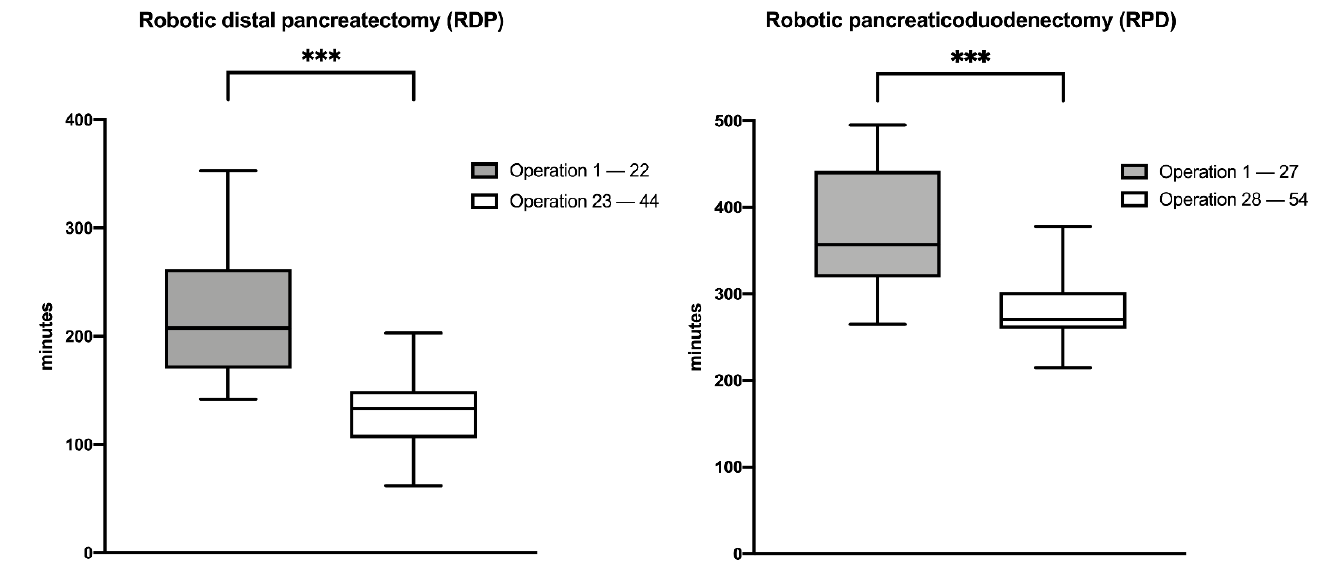
Figure 2. Development of procedure time. Decrease of procedure time comparing the initial and later series for RDP and RPD. *** P ≤ 0.001.